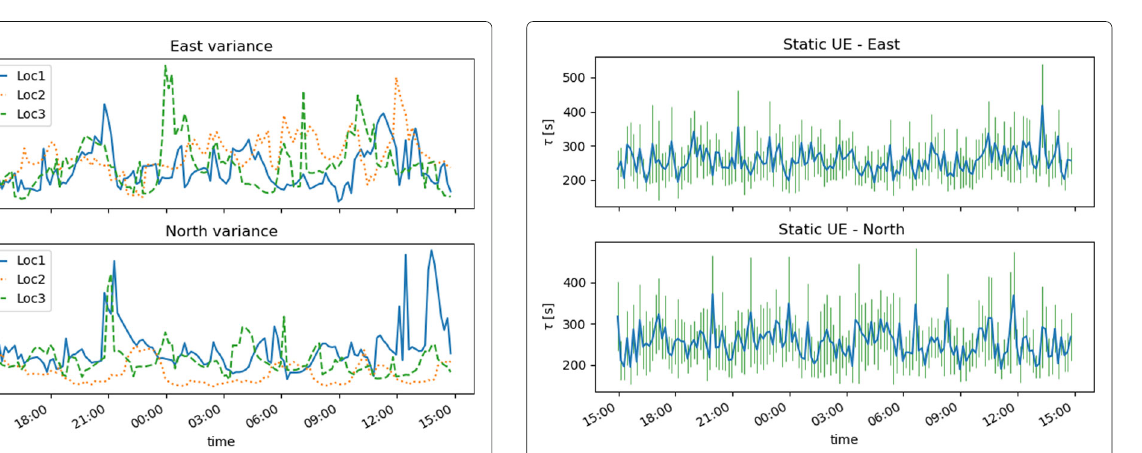
Fig. 14 Comparison between RTK localization error variances obtained at different geographical localization